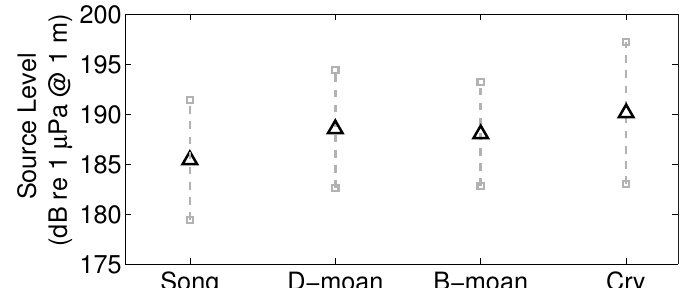
Figure 10. Source level mean and standard deviation of different humpback vocalization types estimated from a subset of received humpback vocalizations consisting of 200 calls within songs, 600 D-moans, 120 B-moans, and 100 cries. The vocalization source level estimates (in units of dB re 1 µ Pa at 1 m) are 185.4 ± 6.0 for song, 188.5 ± 5.9 for D-moans, 188.0 ± 5.2 for B-moans and 190.1 ± 7.1 for cries. These source level estimates are based on the received humpback vocalization time-domain peak pressure levels after correcting for broadband transmission